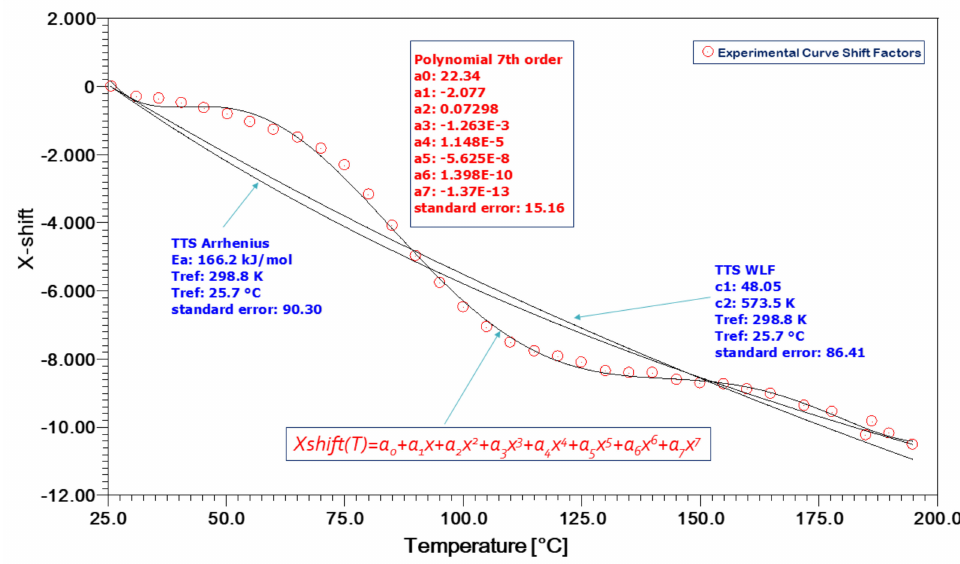
Figure 5. Kevlar/aluminum–glass composite hybrid creep TTS Shift factors